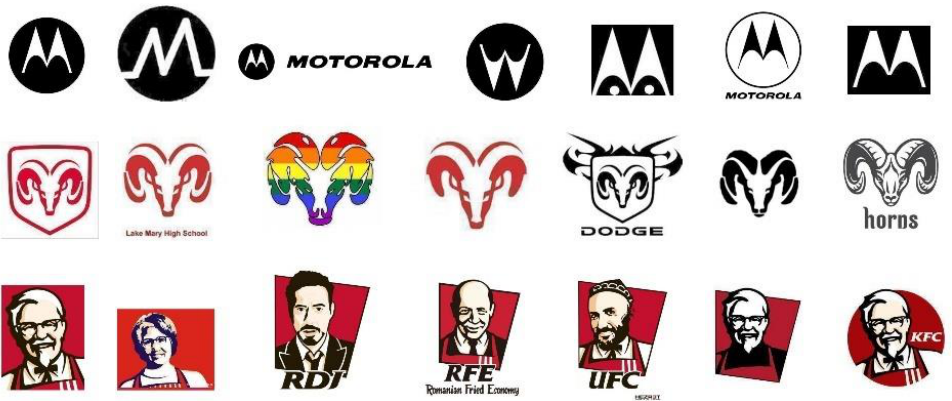
Figure 5. Some images from three groups in the query set.